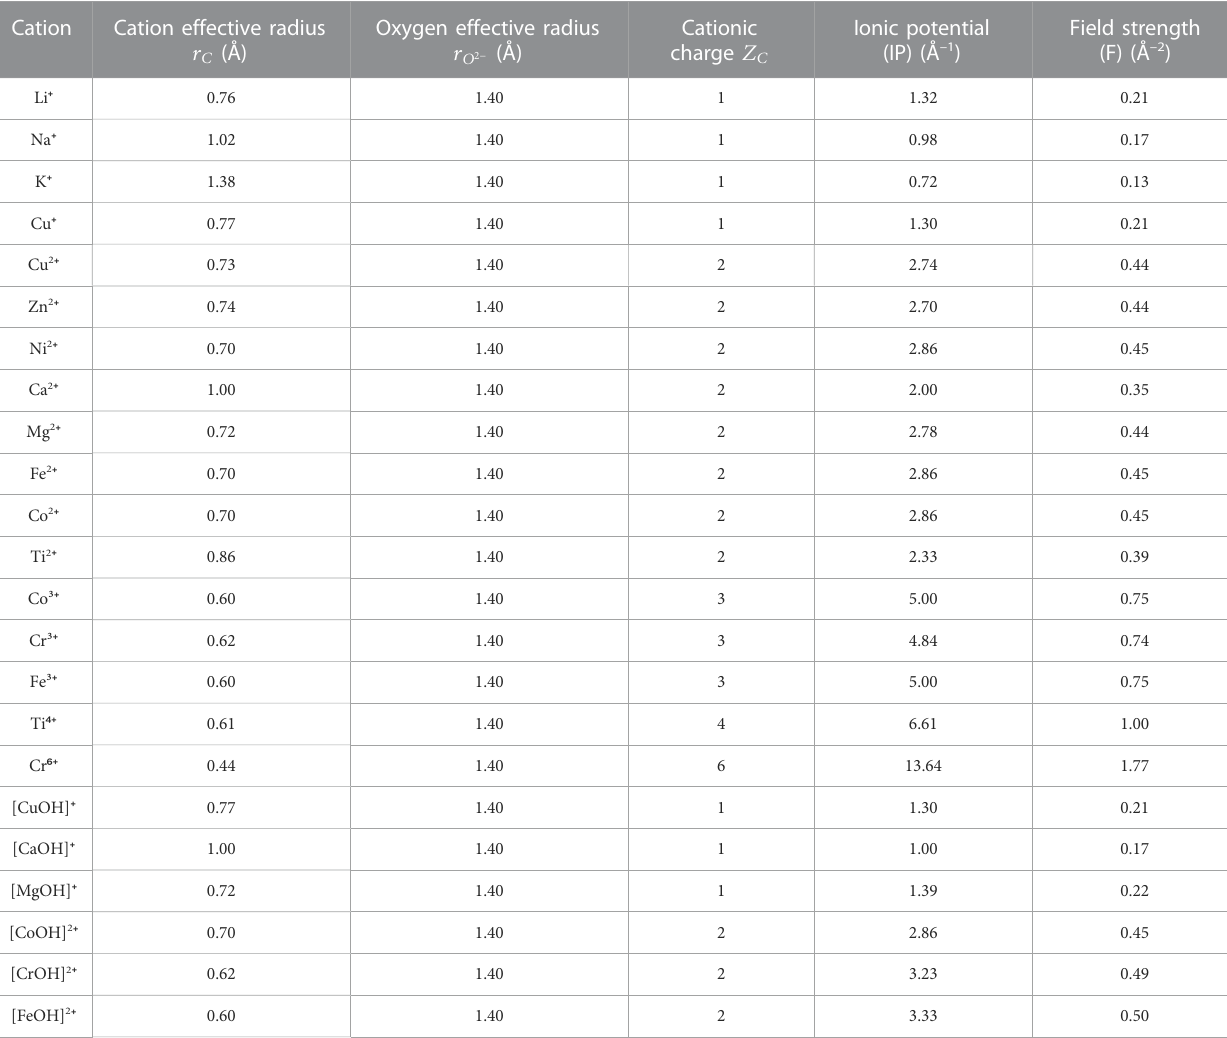
TABLE 2 Summary of effective ionic radii ( r C ) of the studied cations [obtained from Shannon (Shannon, 1976)], along with calculated ionic potential ( Z C / r C ) and fi eld strength ( Z C / ( r C + r O ) 2 2 −